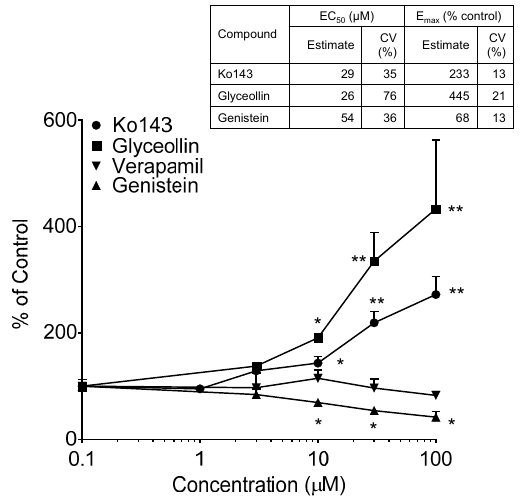
Figure 6. BODIPY-prazosin uptake in Caco-2 cells. Net fluorescence normalized to cell protein was measured following a 30-min incubation with 5 µM BODIPY-prazosin in the presence of varying concentrations of the indicated compounds from 0 µM (control, arbitrarily represented as 0.1 µM on the log-scale) to 100 µM. Results are expressed as the mean + SEM and are based on two separate experiments with n = 4 for each concentration per experiment. * indicates significantly different from the respective compound control ( p < 0.05) from a one-way ANOVA followed by Tukey’s t -test; ** indicates significantly different from the control, 1, 3 and 10 µM conditions. Table insert summarizes the model-derived estimates of EC 50 and E max with associated coefficients of variation (% coefficient of variation) of the estimates.